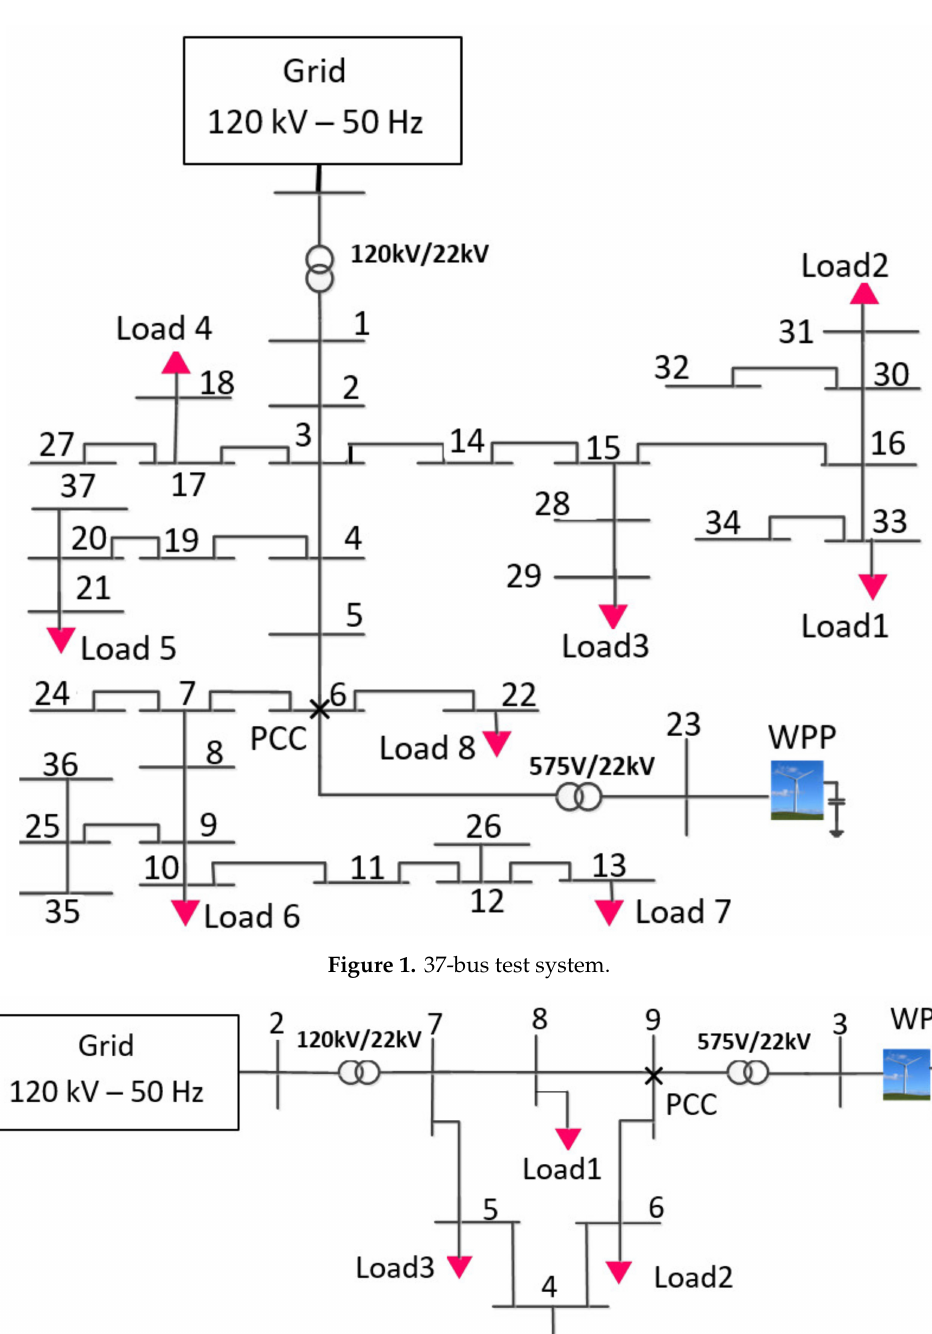
Figure 2. 9-bus test